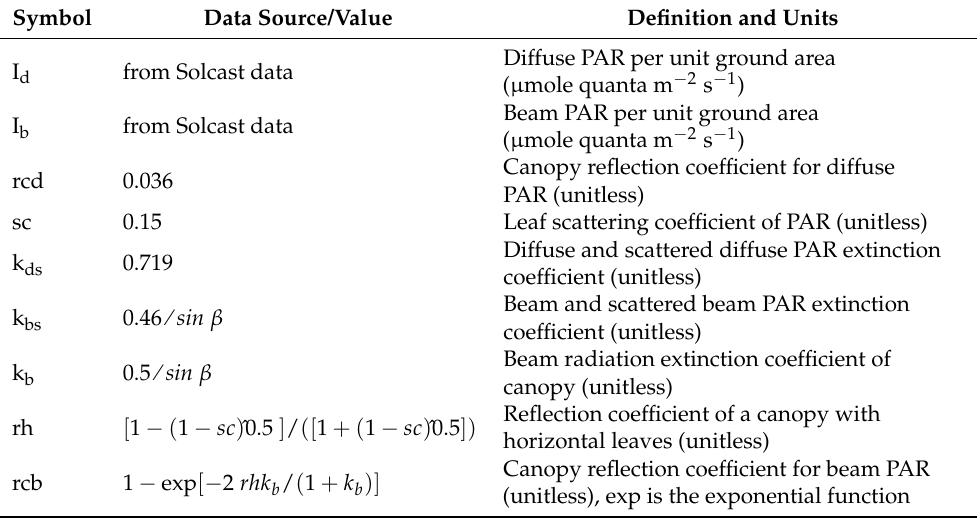
Table A2. Data input and constants used in the Sun/Shade model.